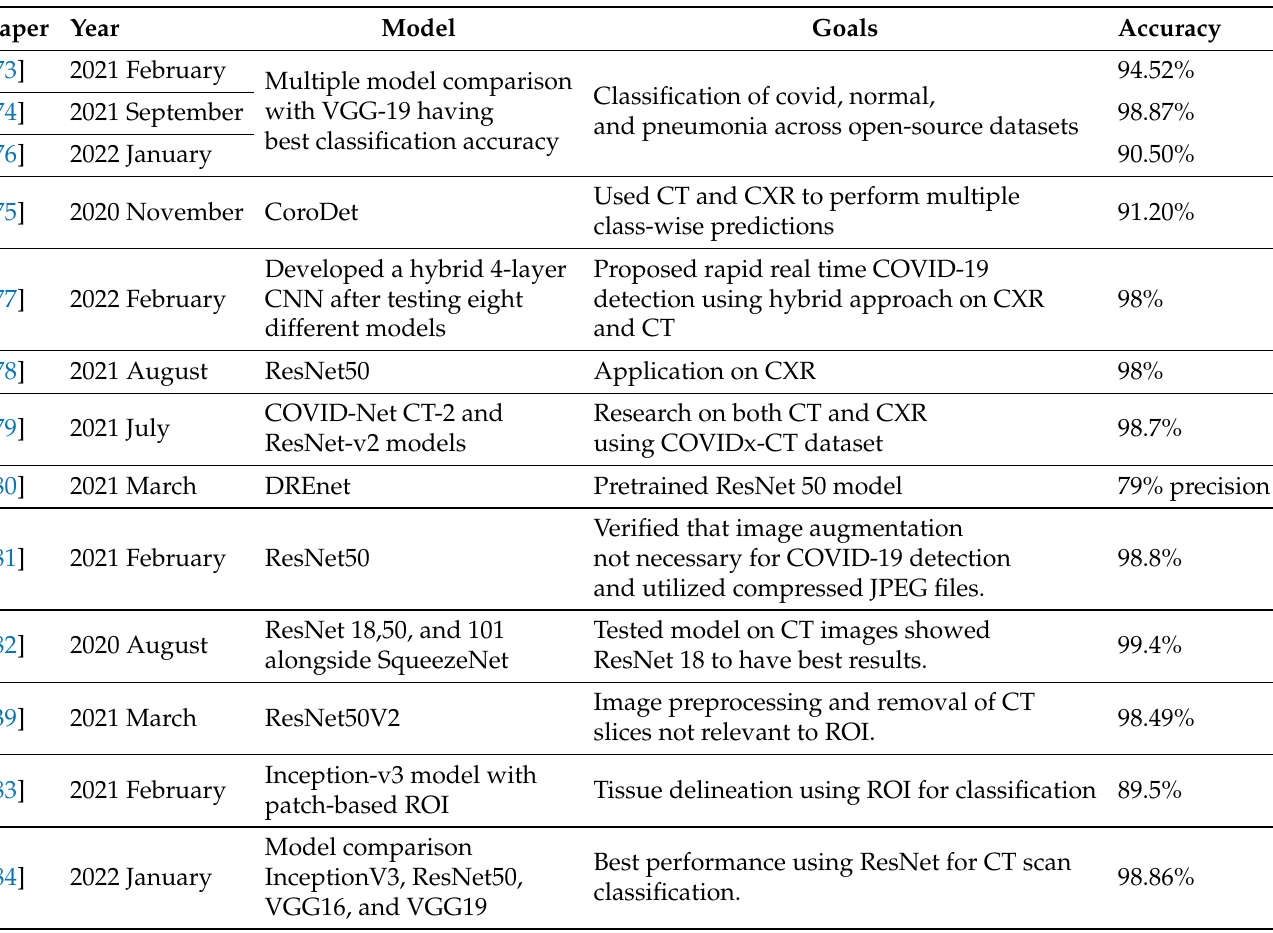
Table 3. Machine learning approach summarized using primarily CT